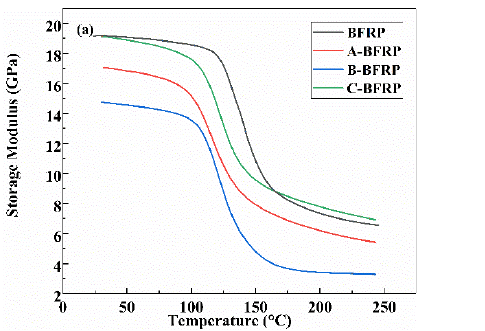
Figure 4. DMA of basalt fiber/epoxy resin composites: ( a ) storage modulus; ( b ) tan  .